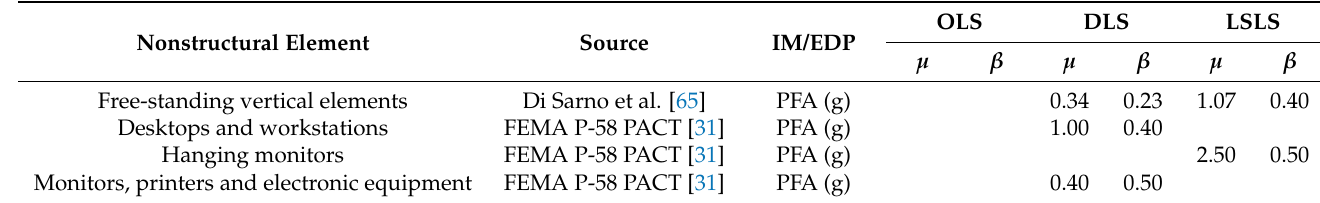
Table 10. Median µ and logarithmic standard deviation β values of the lognormal fragility curves for FF&E nonstructural elements, along with the literature source.